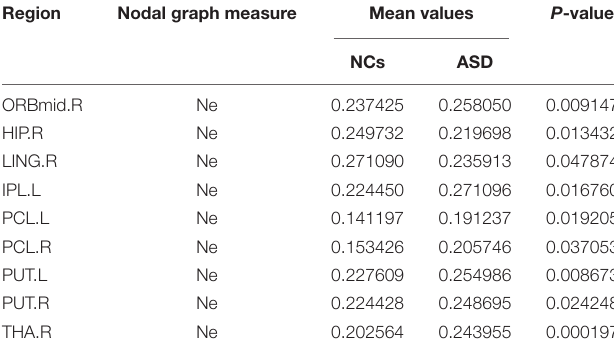
TABLE 8 | Between-group comparison in Ne.